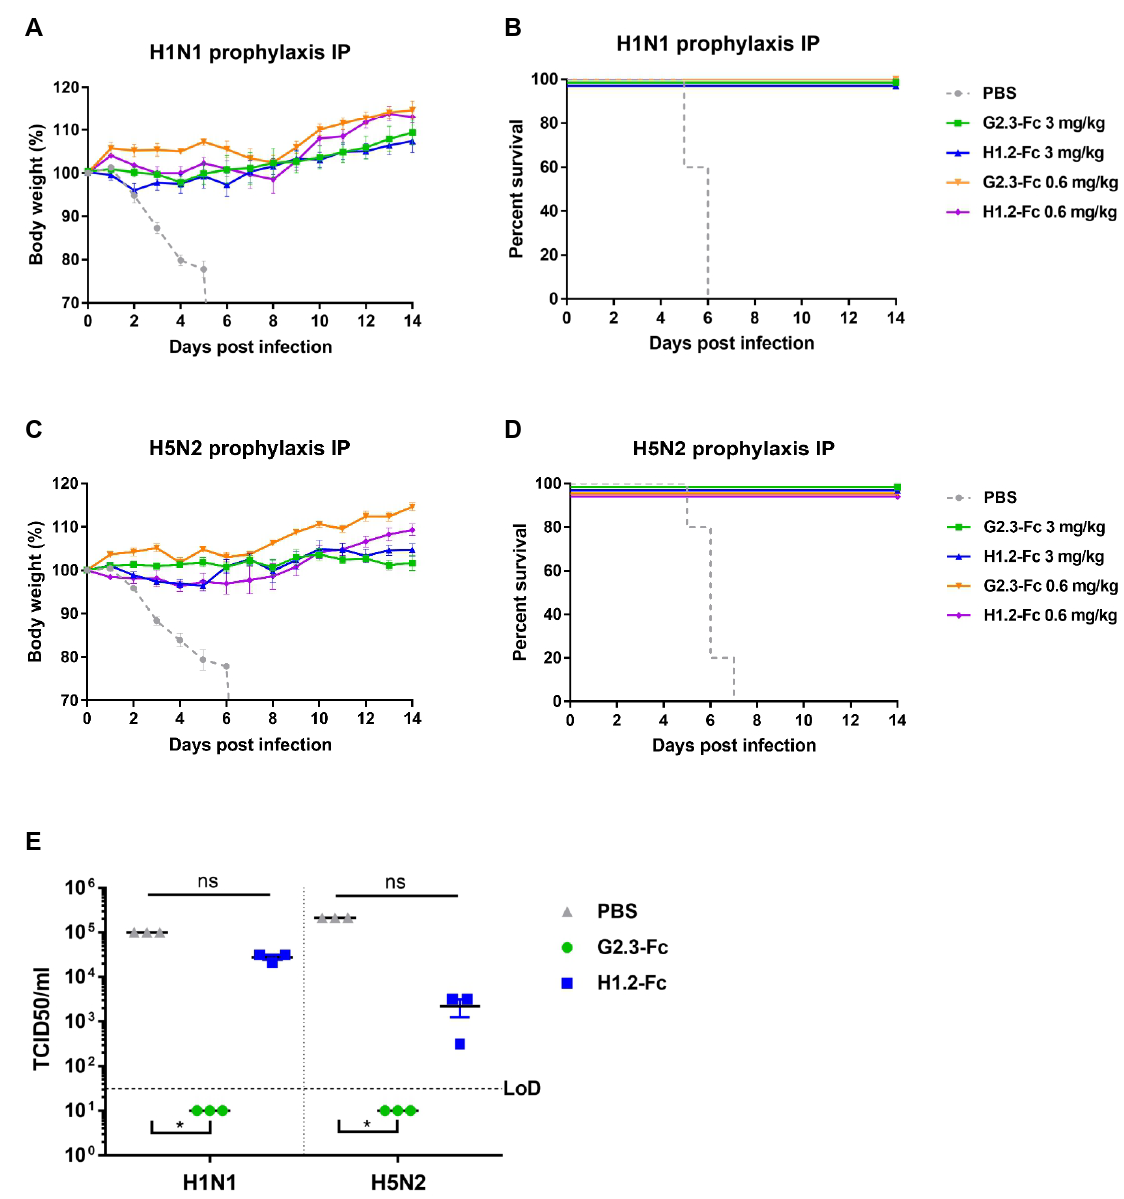
Figure 3. Prophylactic efficacy of systemically administered VHH-Fc in mice. Body weight changes and survival curves of BALB/c mice (n = 5 per group), treated via the i.p. route with G2.3-Fc or H1.2-Fc at different doses 24 h before infection with influenza CA/09(H1N1)ma virus ( A , B ) or duck/PA/84(H5N2)ma virus ( C , D ). As a negative control, a vehicle (PBS) was administered 24 h before infection via the i.p. route. Body weight curves represent mean value ± SEM. ( E ) Lung viral titers following 3 mg/kg G2.3-Fc or H1.2-Fc prophylaxis and H1N1 or H5N2 virus challenge in BALB/c mice. Lung viral titers are expressed in TCID 50 per milliliter. Error bars represent means ± SEM. Asterisks indicate significant differences from the control group (*, p = 0.0105; ns—non-significant).